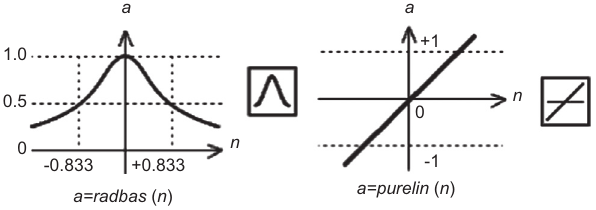
Figure 6. Radial Basis and Purelin Function Used in GRNN